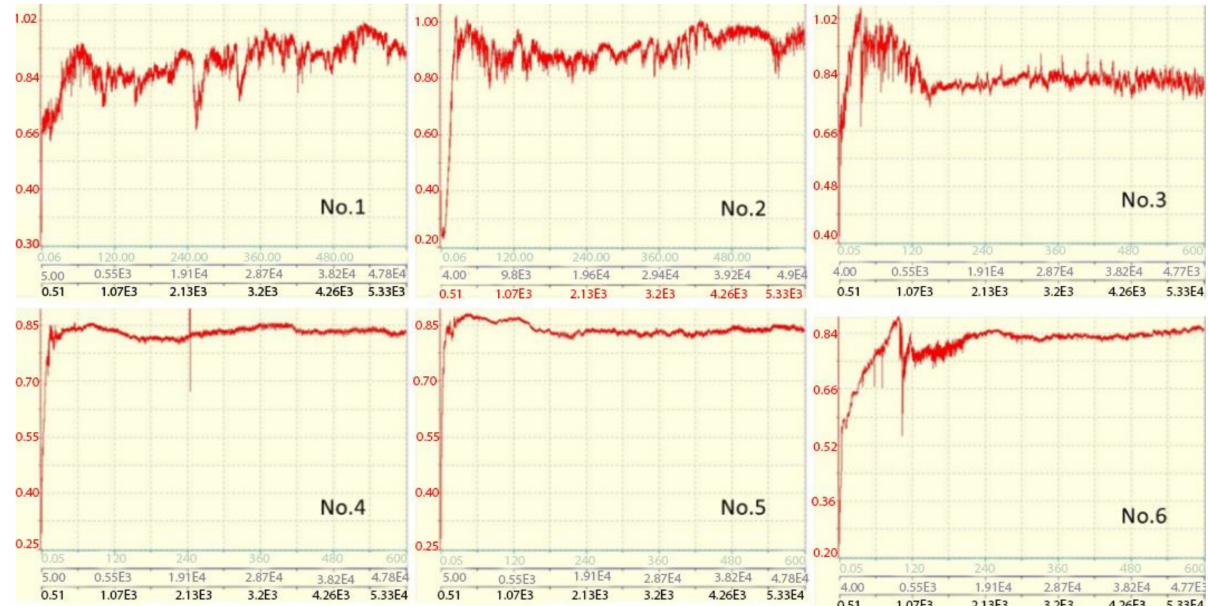
Figure 8. Dependence of the friction coefficient of (TiZrNb)N coatings on the distance, number of cycles and experiment time.